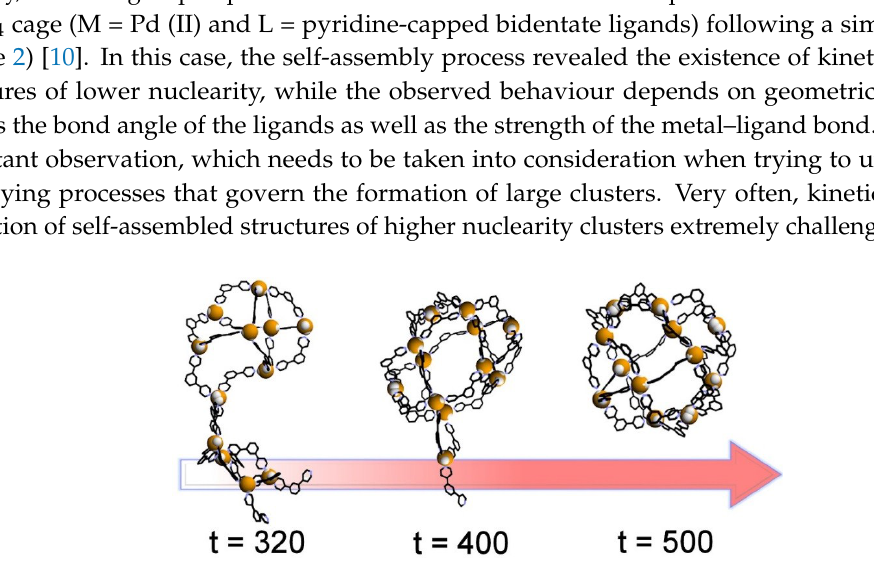
Figure 2. Structural changes during the self-assembly process. Adapted from ACS Nano 2014 , 8 (2), 1290–1296. Copyright (2014) American Chemical Society.